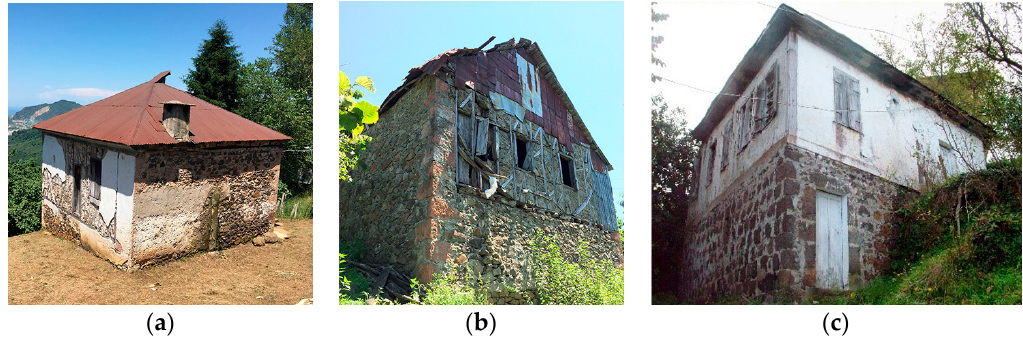
Figure 9. Vernacular buildings sited on sloping territories from ( a ) Ordu; ( b ) Trabzon; ( c ) Giresun (Photographed by Ömer Faruk Bayram).